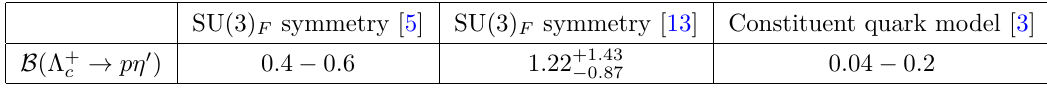
Table 1 . Comparison of different theoretical predictions for B (Λ +